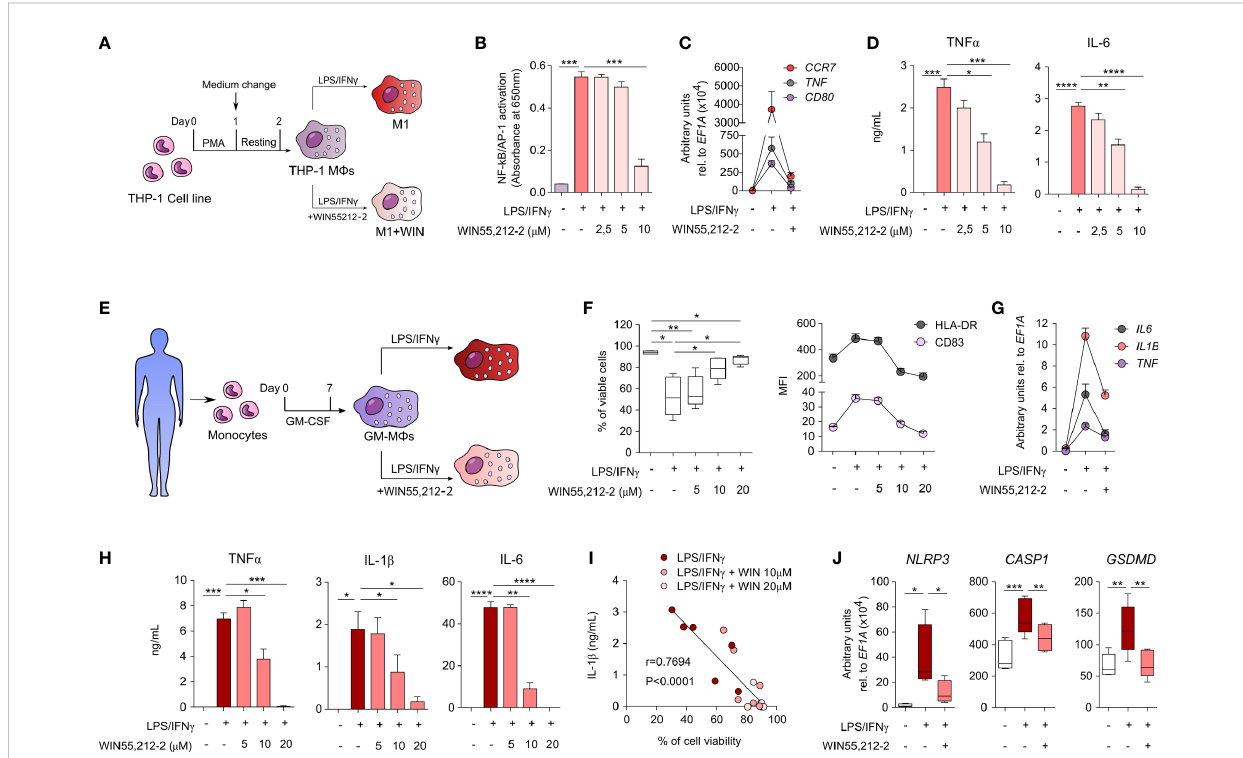
FIGURE 2 WIN55,212-2 inhibits pro-in fl ammatory activation of human macrophages. (A) THP-1 M F s generation and activation protocol. (B) NF- k B/AP-1 activation in THP-1 XBlue M F s after 18h of stimulation with medium, LPS/IFN g (100 ng/mL and 50 ng/mL, respectively) or LPS/IFN g plus the indicated doses of WIN55,212-2 (n=6). (C) mRNA expression levels of the indicated genes after 18h of stimulation of THP-1 M F s with medium, LPS/ IFN g or LPS/IFN g plus WIN55,212-2 (10 m M) (n=5). (D) Cytokine production by THP-1 M F s stimulated with medium, LPS/IFN g or LPS/IFN g plus the indicated doses of WIN55,212-2 (n=6). (E) Protocol of human GM-M F s differentiation and activation. (F) Percentage of viable cells (left) and mean fl uorescence intensity (MFI) of the indicated markers (right) after GM-M F s stimulation with medium, LPS/IFN g (100 ng/mL and 50 ng/mL) or LPS/IFN g plus the indicated doses of WIN55,212-2 (n=6). (G) mRNA expression levels of the indicated cytokines after 4h stimulation of GM-M F s with medium, LPS/IFN g or LPS/IFN g plus WIN55,212-2 (20 m M) (n=5). (H) Cytokine production after 18h stimulation of GM-M F s with medium, LPS/IFN g or LPS/IFN g plus the indicated doses of WIN55,212-2 (n=6). (I) Correlation between IL-1 b production and GM-MØ viability after stimulation with LPS/IFN g and LPS/IFN g plus the indicated doses of WIN55,212-2 (n=6). (J) mRNA expression levels of the indicated genes after 4h stimulation of GM-M F s with medium, LPS/IFN g or LPS/IFN g plus WIN55,212-2 (20 m M) (n=5). Values are shown as mean ± SEM. Statistical signi fi cance was determined by One- way ANOVA (B, D, F, H, J) or Spearman test (I) . *P<0.05, **P<0.01, ***P<0.001 and